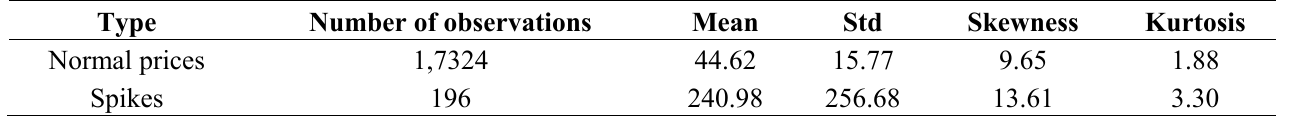
Table 1. Basic statistics for normal spot prices and price spikes in terms of